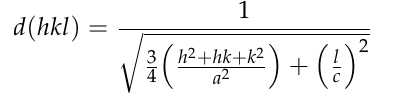
Figure 5. Cross sections of the PLSD kerfs along different crystal orientations or planes. ( a ) The cross section of crystal plane {10−10} and ( b ) the cross section of crystal plane {11−20}.